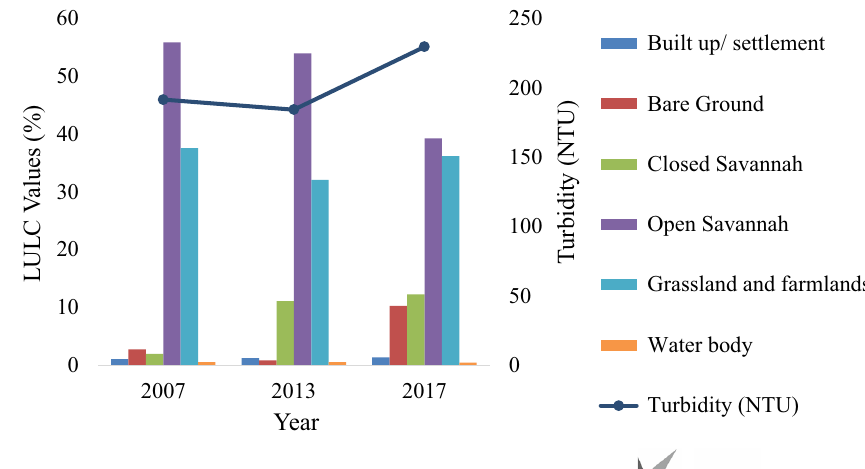
Fig. 8 Relationship between changing turbidity and LULCC in the Nawuni